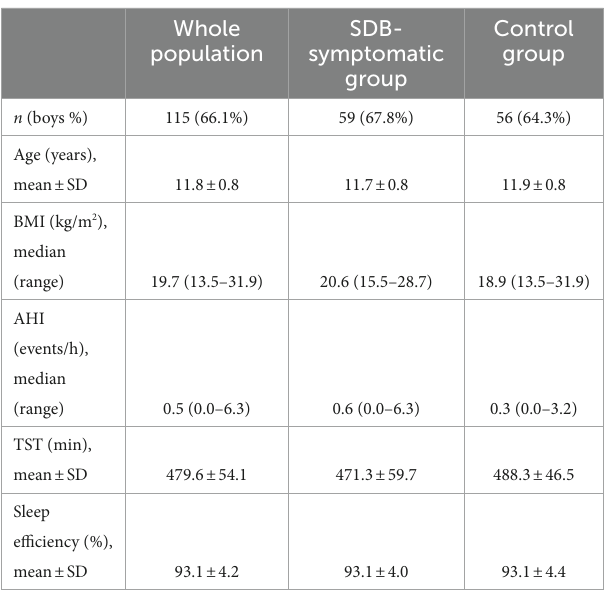
TABLE 1 The demographics and characteristics of the study population.